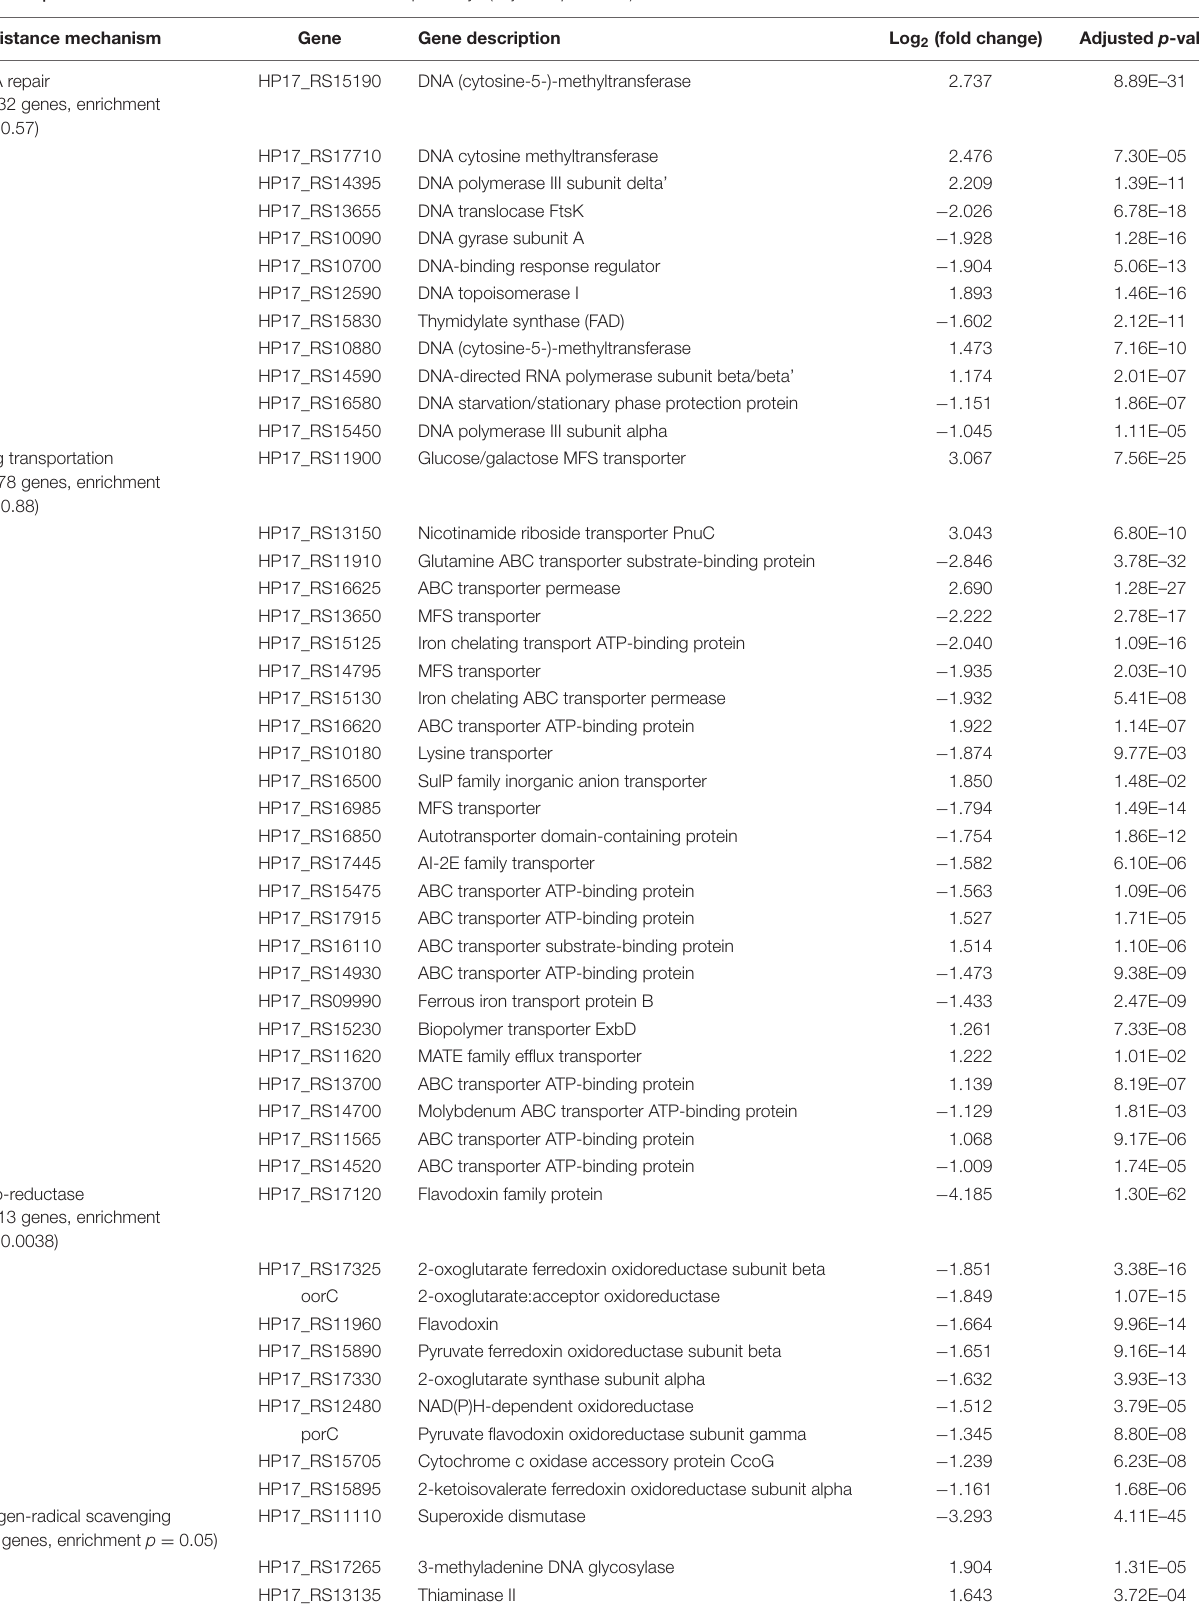
TABLE 1 | Curation of DEGs into metronidazole resistance pathways (adjusted p < 0.05). Resistance mechanism Gene Gene description Log 2 (fold change) Adjusted p -value DNA repair (12/32 genes, enrichment p =